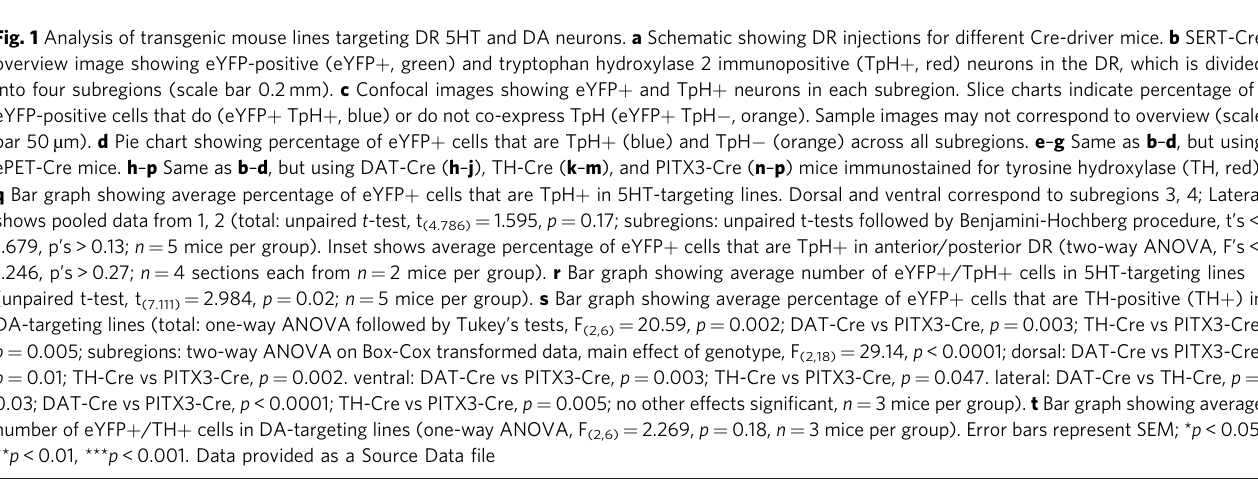
Fig. 1 Analysis of transgenic mouse lines targeting DR 5HT and DA neurons. a Schematic showing DR injections for different Cre-driver mice. b SERT-Cre overview image showing eYFP-positive (eYFP + , green) and tryptophan hydroxylase 2 immunopositive (TpH + , red) neurons in the DR, which is divided into four subregions (scale bar 0.2 mm). c Confocal images showing eYFP + and TpH + neurons in each subregion. Slice charts indicate percentage of eYFP-positive cells that do (eYFP + TpH + , blue) or do not co-express TpH (eYFP + TpH − , orange). Sample images may not correspond to overview (scale bar 50 µ m). d Pie chart showing percentage of eYFP + cells that are TpH + (blue) and TpH − (orange) across all subregions. e – g Same as b – d , but using ePET-Cre mice. h – p Same as b – d , but using DAT-Cre ( h – j ), TH-Cre ( k – m ), and PITX3-Cre ( n – p ) mice immunostained for tyrosine hydroxylase (TH, red). q Bar graph showing average percentage of eYFP + cells that are TpH + in 5HT-targeting lines. Dorsal and ventral correspond to subregions 3, 4; Lateral shows pooled data from 1, 2 (total: unpaired t -test, t (4.786) = 1.595, p = 0.17; subregions: unpaired t-tests followed by Benjamini-Hochberg procedure, t ’ s < 1.679, p ’ s > 0.13; n = 5 mice per group). Inset shows average percentage of eYFP + cells that are TpH + in anterior/posterior DR (two-way ANOVA, F ’ s